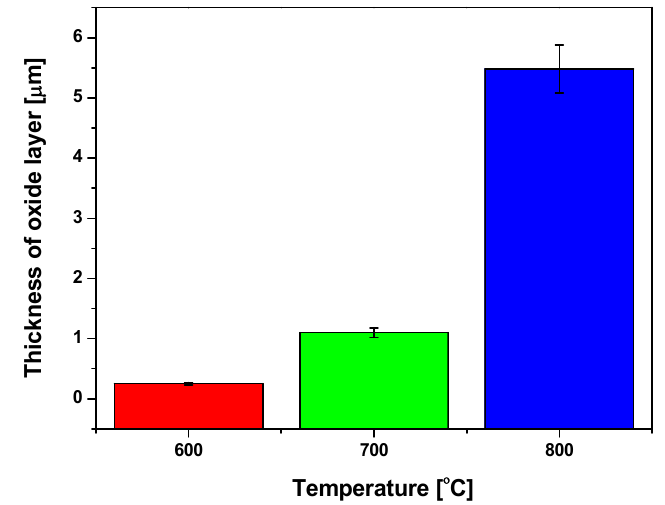
Figure 2. The mean thickness of oxide layers on the Ti-6Al-7Nb alloy depending on the temperature of isothermal oxidation; letters placed above each column indicate that the mean thickness of oxide layers is statistically different from one another.